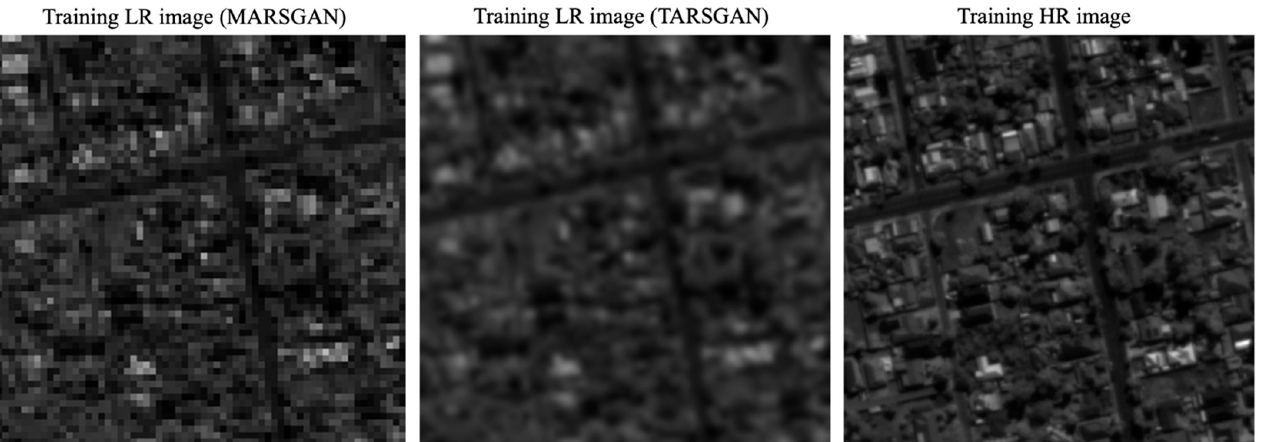
Figure 2. An example of the MARSGAN training LR image (4 times down-sampled version of the training HR image – similar to using the 4m MS band image), the TARSGAN training LR image (created via 4 times down-sampling, 4 times up-sampling, and Gaussian blurring), and the training HR image (same for both MARSGAN and TARSGAN). Image dimensions: 256m × 256m. Deimos-2 image courtesy of Deimos Imaging, S.L. 2021.